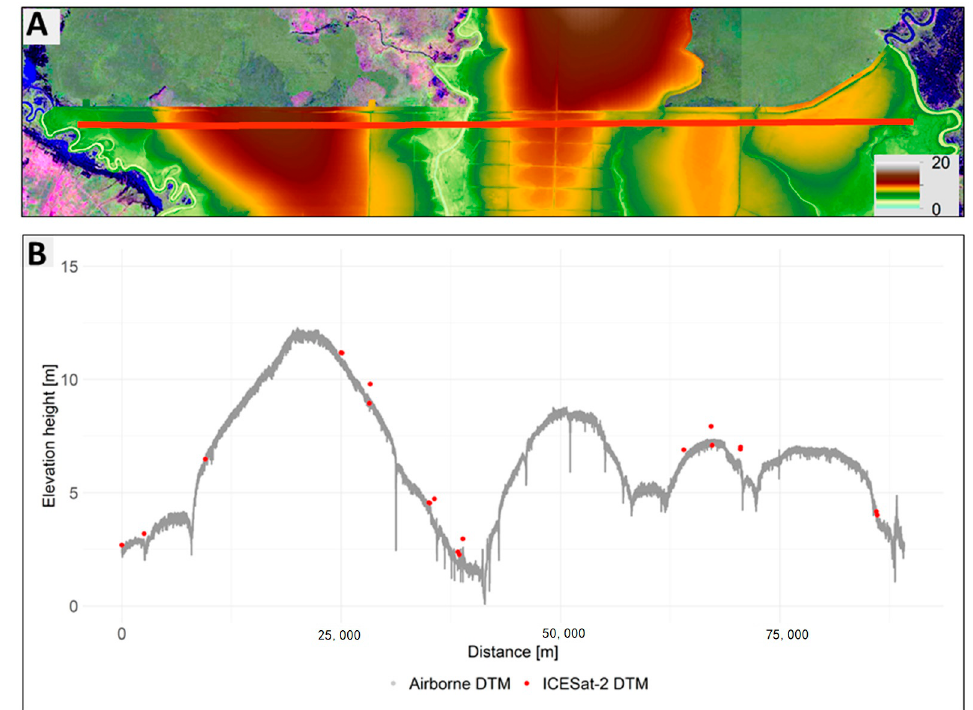
Figure 5. Comparison of the airborne DTM and ICESat-2 DTM along an 88 km-long transect (red line) across four large peat domes. The four peat domes are clearly visible by their convex curvature. ( A) The airborne DTM covers an elevation range of 3 to 12 m displayed in green to brown colors. ( B ) Height profile of the transect from west to east. The gray line represents the airborne LiDAR DTM and the red dots show the corresponding ICESat-2 DTM.